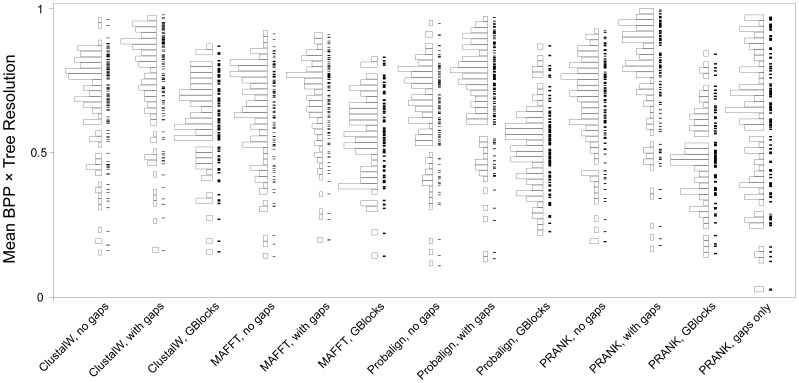
The impact of various gap treatments on ‘tree support’ calculated as the product of 50% majority rule consensus tree resolution and the mean of the posterior probabilities of resolved nodes.Thus, for instance, a value of 1.0 means that the consensus tree is fully resolved and the posterior probability is 1.00 for each node. Each panel reflects the distribution of ‘tree support’ values for each of the analyzed datasets (115 on average, minus failed analyses). The figure shows that the inclusion of indel data increases tree support under all alignment algorithms, except for MAFFT-X-INS-I, whereas the exclusion of ambiguously aligned sites (by GBlocks) reduces tree support for all alignments. The differences are most pronounced for PRANK+F, which inferred on average the highest number of indels and gapped sites (see text).